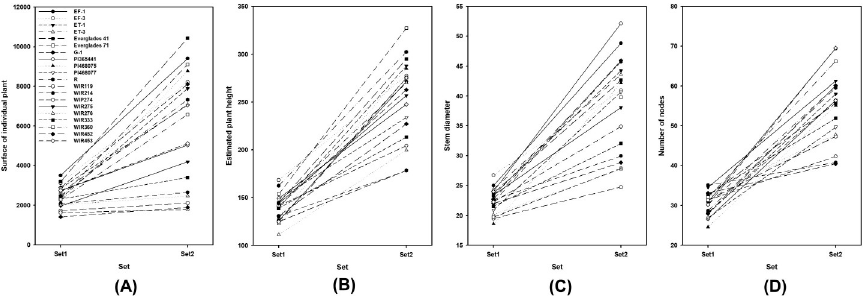
Fig 3. Growth of kenaf ( Hibiscus cannabinus L.) entry traits affecting biomass production at two different growth stages. (A) Surface of the individual plant (cm 2 ), (B) Expected plant height (mm), (C) Stem diameter (mm), and (D) Number of nodes of 20 kenaf entries at two different growth stages. Set 1 and Set 2 measured June 22 and August